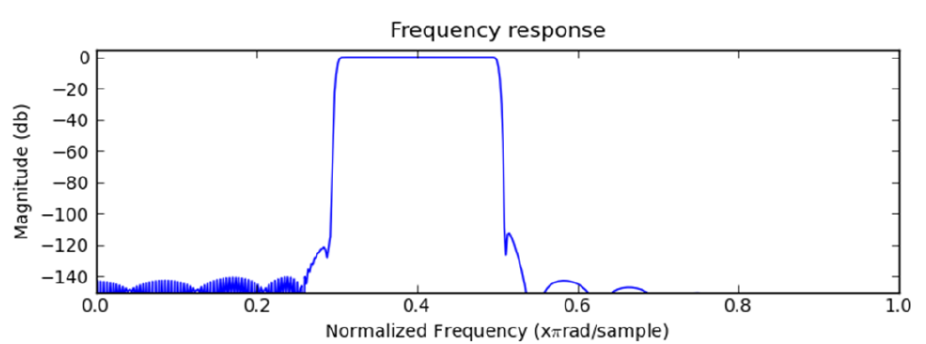
Figure 4. Used FIR filter window